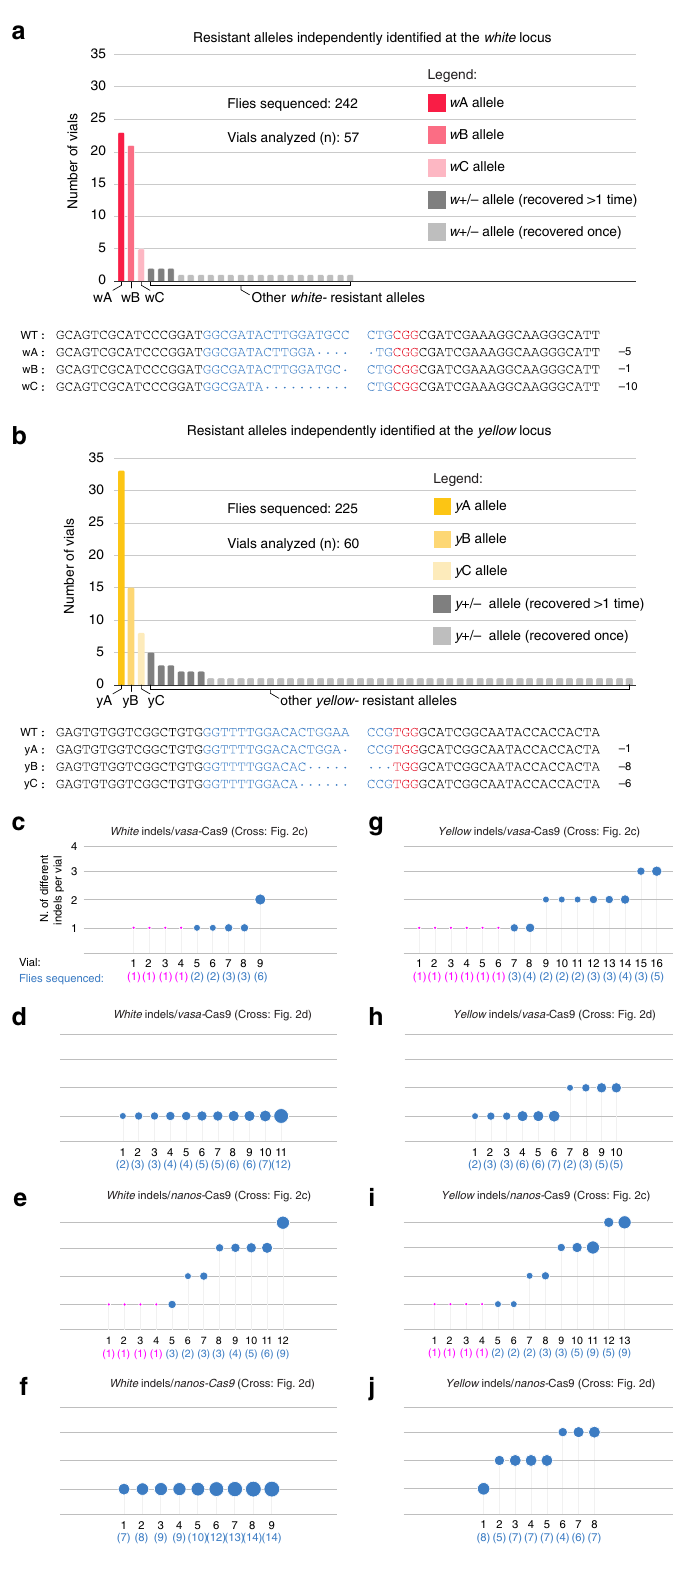
Yellow indels/ nanos- Cas9 (Cross: Fig. 2d)